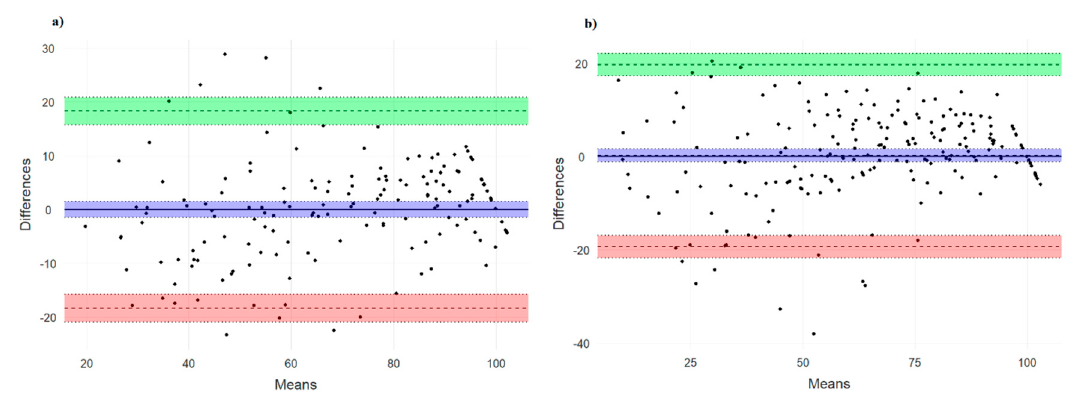
Figure 2. Altman plots representing the Bland central line and 95% limits of agreement between two methods. ( a ) leg press; ( b ) bench press. Table 4. Bland-Altman differences between methods.